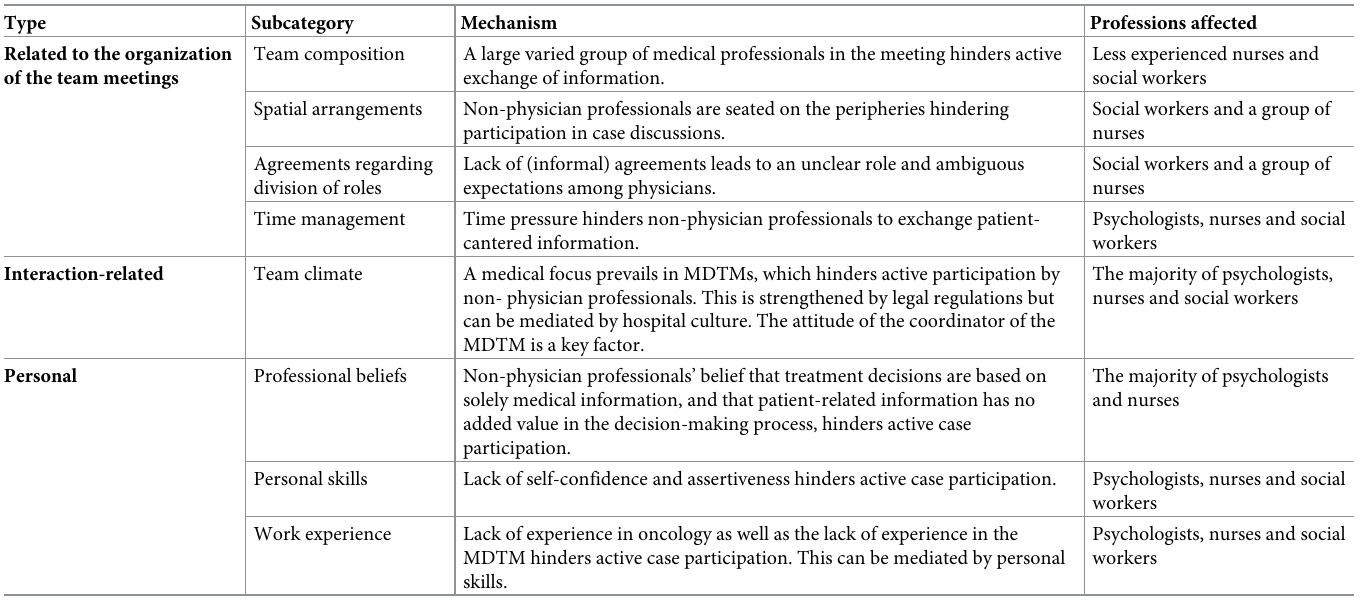
Table 3. Team-related barriers to non-physician cancer care professionals taking up an active role during MDTMs.